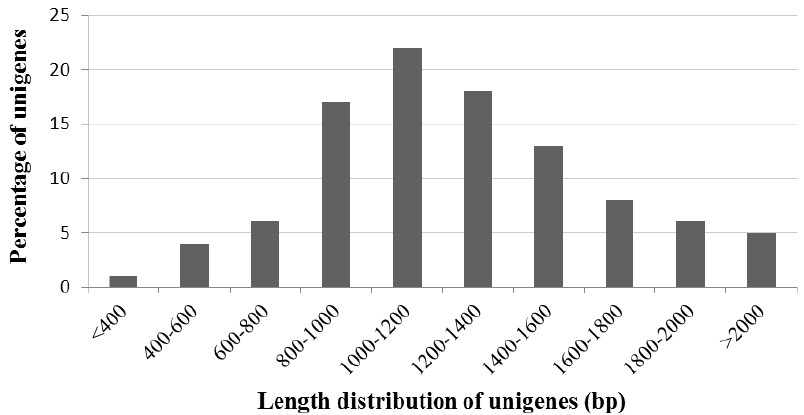
Figure 1. Comparison of unigene length.